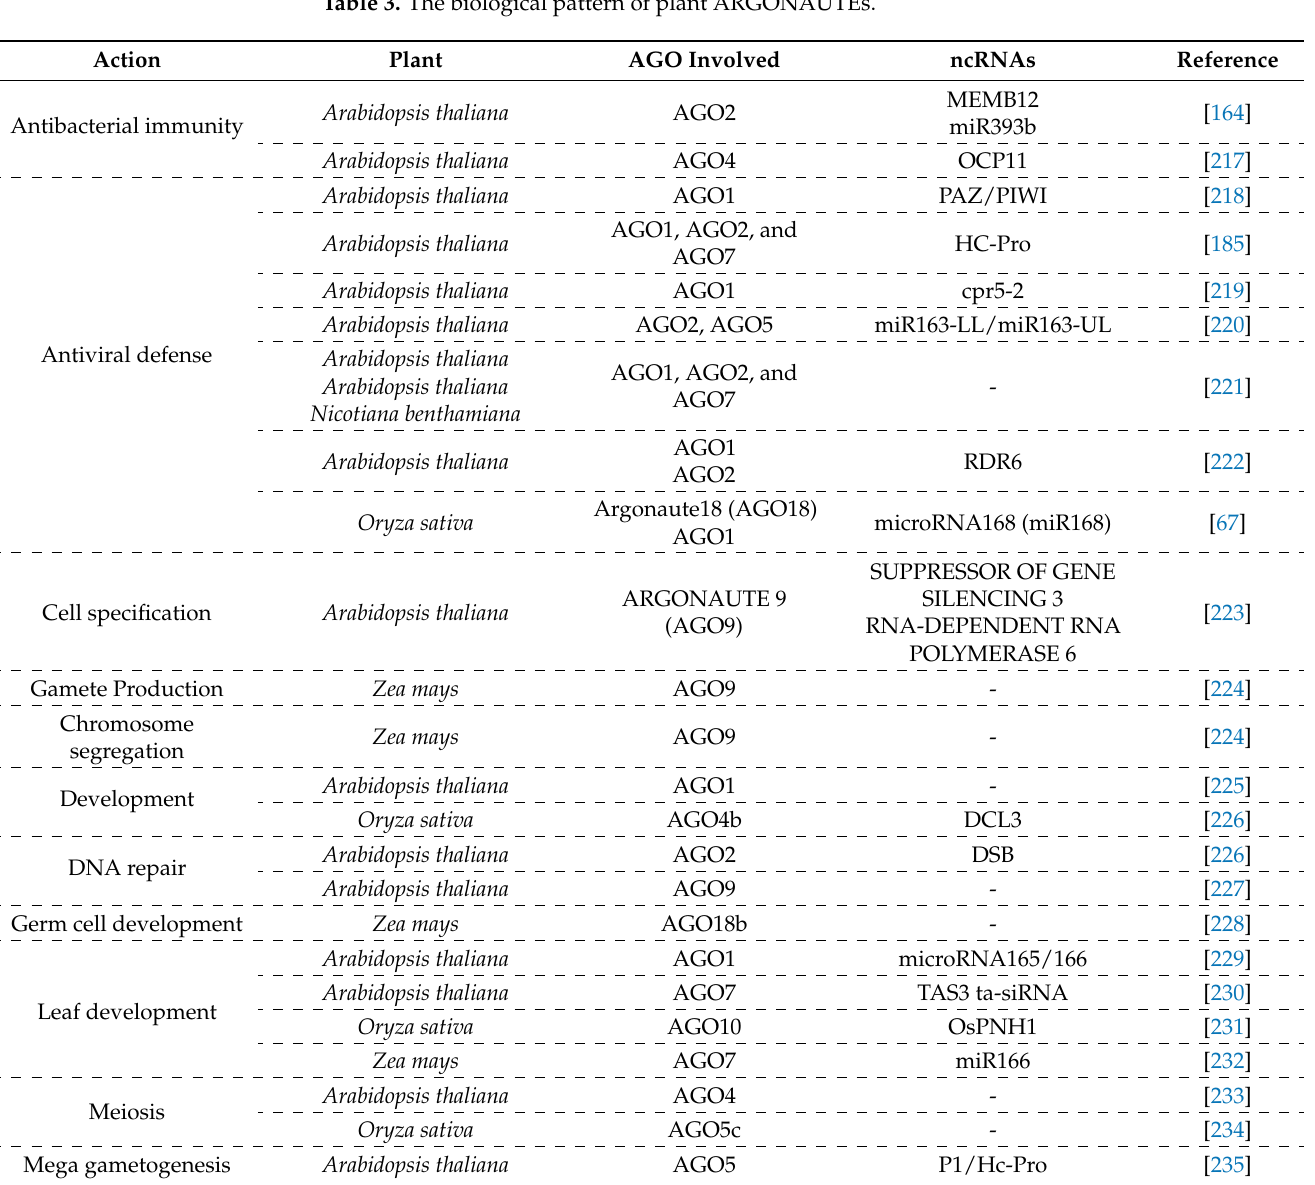
Table 3. The biological pattern of plant